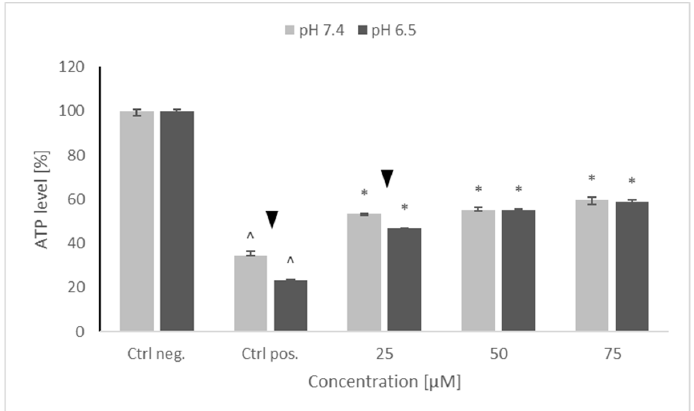
Figure 4. ATP levels after pretreatment of SH-SY5Y cells with NRNPs pH and exposure to 6-hydroxydopamine. The whiskers are lower (25%) and upper (75%) quartile ranges. ^ p ≤ 0.05, Kruskal–Wallis test vs. the negative control (Ctrl neg.; cells not treated with 6-OHDA), ▼ p ≤ 0.05, Mann–Whitney U test; differences between the different pH conditions (pH 7.4 vs. pH 6.5), * p ≤ 0.05, Kruskal–Wallis test vs. positive control (Ctrl pos.; cells treated with 6-OHDA only, without any pretreatment); n = 9.